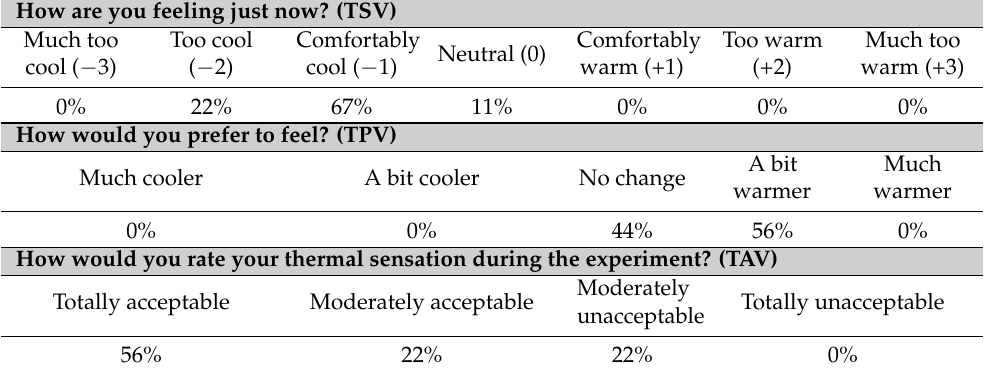
Table 6. Thermal sensation vote and preferences of the occupants.